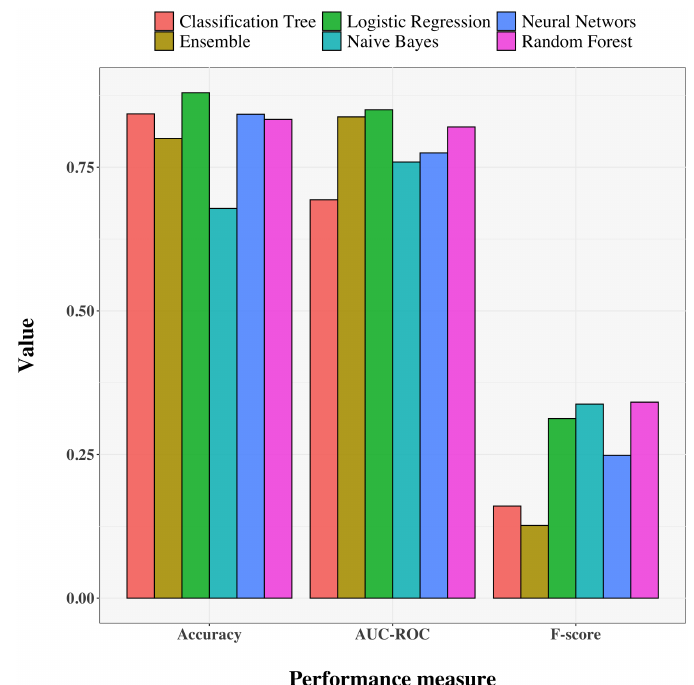
Figure 3. Barplots of the results of the models.